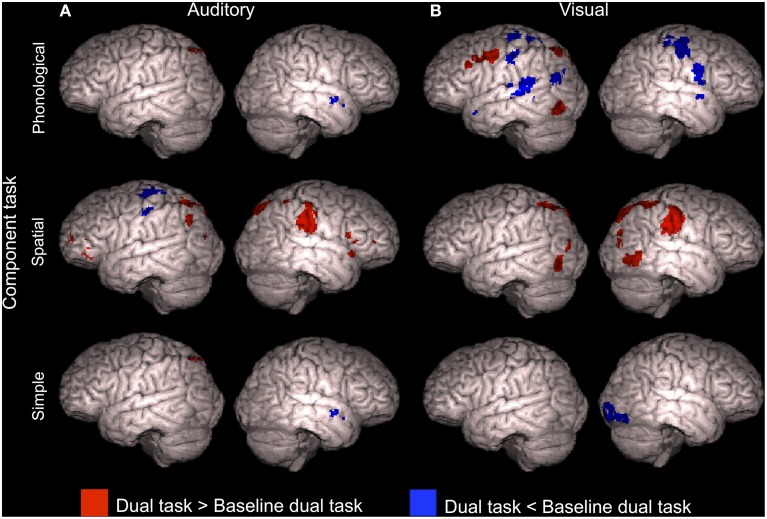
Brain activity during dual tasks including a certain component tasks. Areas showing significant (Z > 2.3, cluster corrected P < 0.05) activity during dual tasks including (A) auditory phonological (APhonVPhon, APhonVSpat, and APhonVSimp), spatial (ASpatVPhon, ASpatVSpat, and ASpatVSimp) or simple (ASimpVPhon and ASimpVSpat) component task and (B) dual tasks including the visual phonological (APhonVPhon, ASpatVPhon, and ASimpVPhon), spatial (APhonVSpat, ASpatVSpat, and ASimpVSpat) or simple (APhonVSimp and ASpatVSimp) component task compared with ASimpVSimp, the baseline dual task.